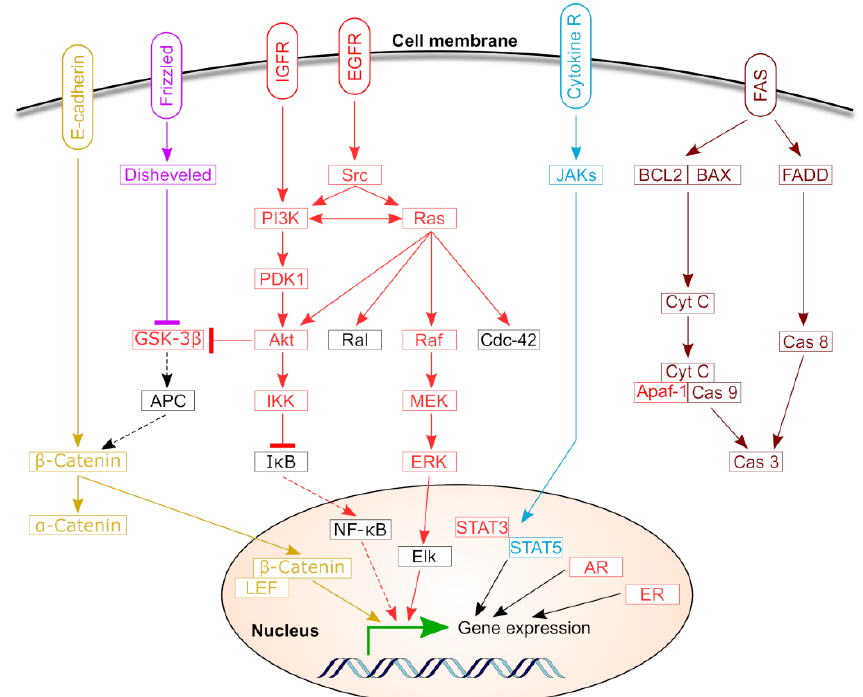
Figure 3. HSP90 functions as a mediator of many oncogenic and signaling pathways [21]. Several oncogenic proteins (shown in red) require HSP90 chaperonage for their proper folding and stabilization. For instance, HSP90 impacts the activity and/or function of receptor tyrosine kinases, serine-threonine kinases, steroid receptors, Src family members, telomerases and cell cycle proteins. Other distinctive pathways regulated by HSP90 are illustrated in different colors, including apoptotic pathway (brown), JAK/STAT pathway and cell-adhesion and Wnt-signaling (purple and light brown).